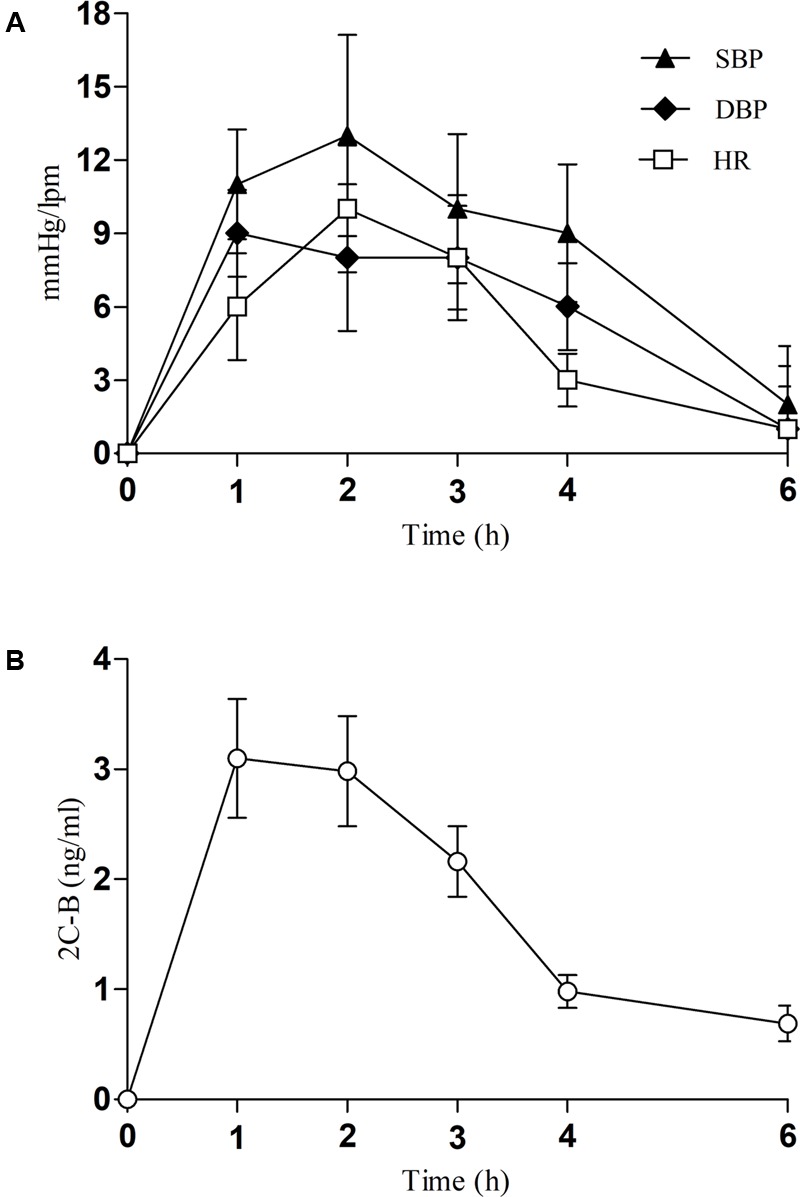
(A) Time course of changes from baseline for systolic and diastolic blood pressure (SBP, DBP, mmHg) and heart rate (HR, bpm, beats per minute) (n = 16, mean, standard error). (B) Time course of 2C-B concentrations in oral fluid (n = 16, mean, standard error).